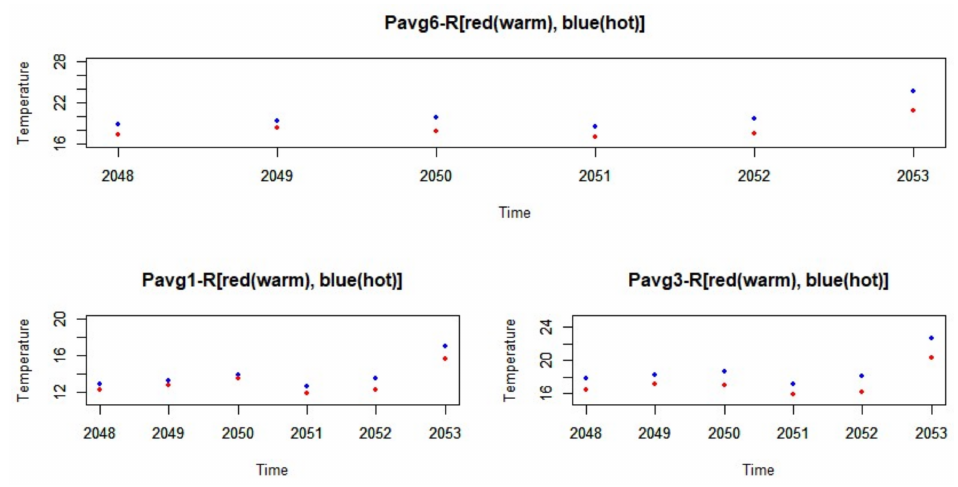
Figure 40. RCP 4.5 hot model (MIROC-ESM-CHEM) and RCP 4.5 warm model (IPSL-CM5A-MR) predictions for the period 2048–2053 (full dam steady-state), temperature in ◦ C.